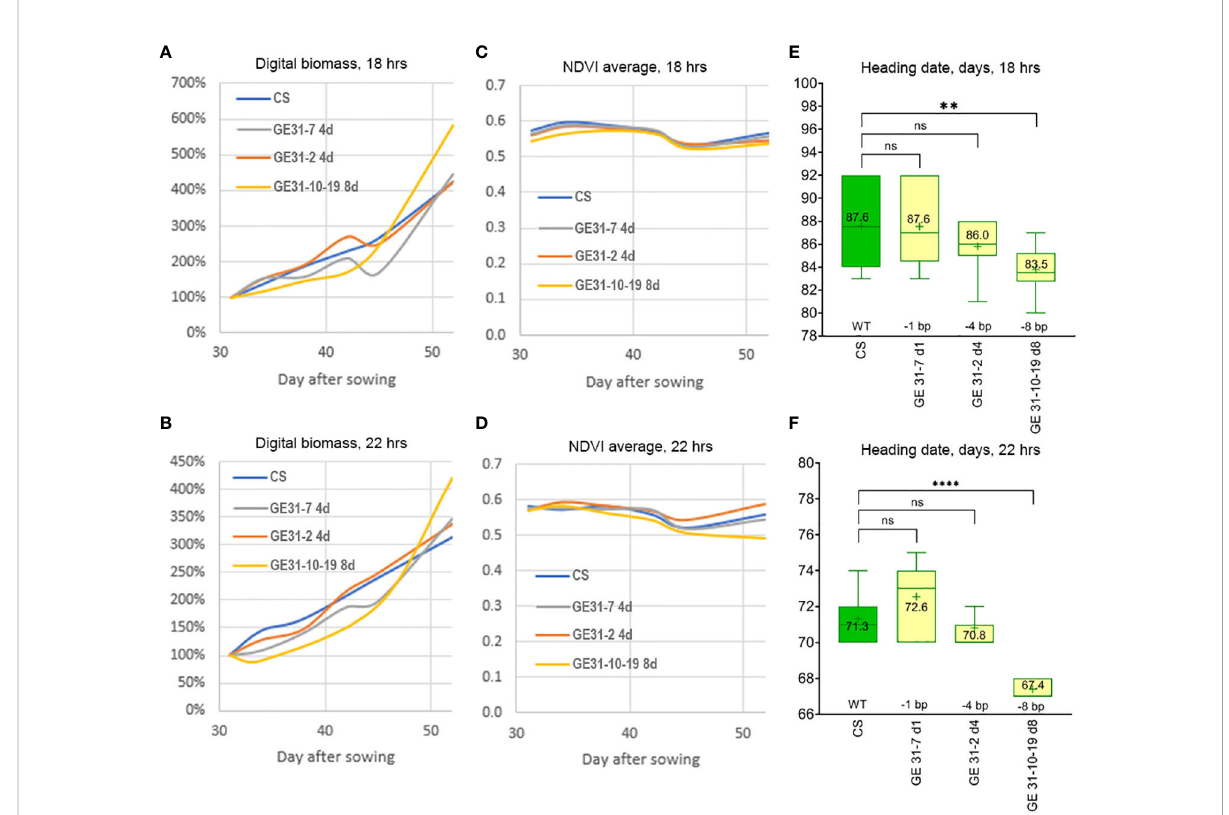
FIGURE 4 Evaluation of the growth habit of genome-edited wheat lines using growth chamber under two environmental regimes: (A, C, E) 18 h photoperiod at 22 ± 0.5°C; (B, D, F) 22 h photoperiod at 17 ± 0.5°C. A 3D model of wheat pots painted with NDVI-compliant pseudocolors. Changes in average values of (A, B) digital biomass and (C, D) NDVI of wheat plants between 30 and 50 days after sowing, determined with Trait Finder digital phenotyping system. Heading time of wheat lines under an (E) 18 h and (F) 22 h photoperiod; signi fi cant differences between the lines are shown according to Turkey ’ s multiple range test (** p < 0.005; **** p < 0.0005; ns: nonsigni fi cant).